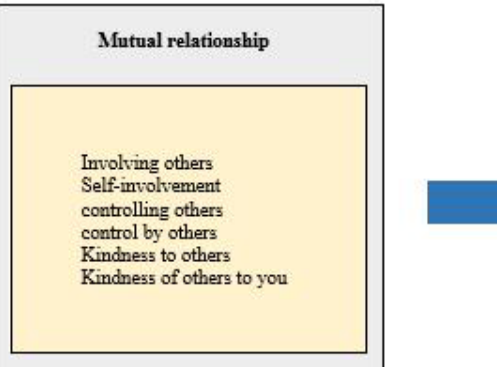
Fig. 1: Conceptual model of the